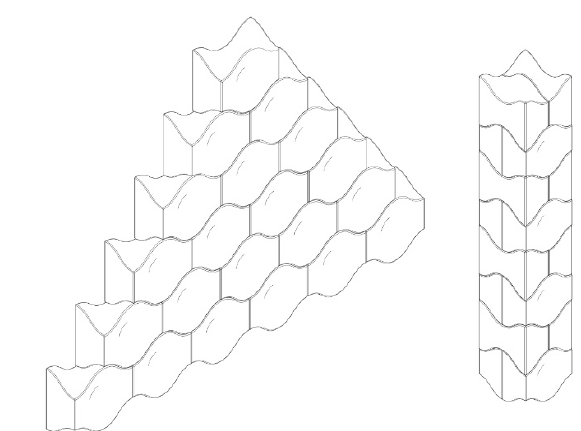
Fig.9: Illustration of possible structural geometries using osteomorphic blocks (Type